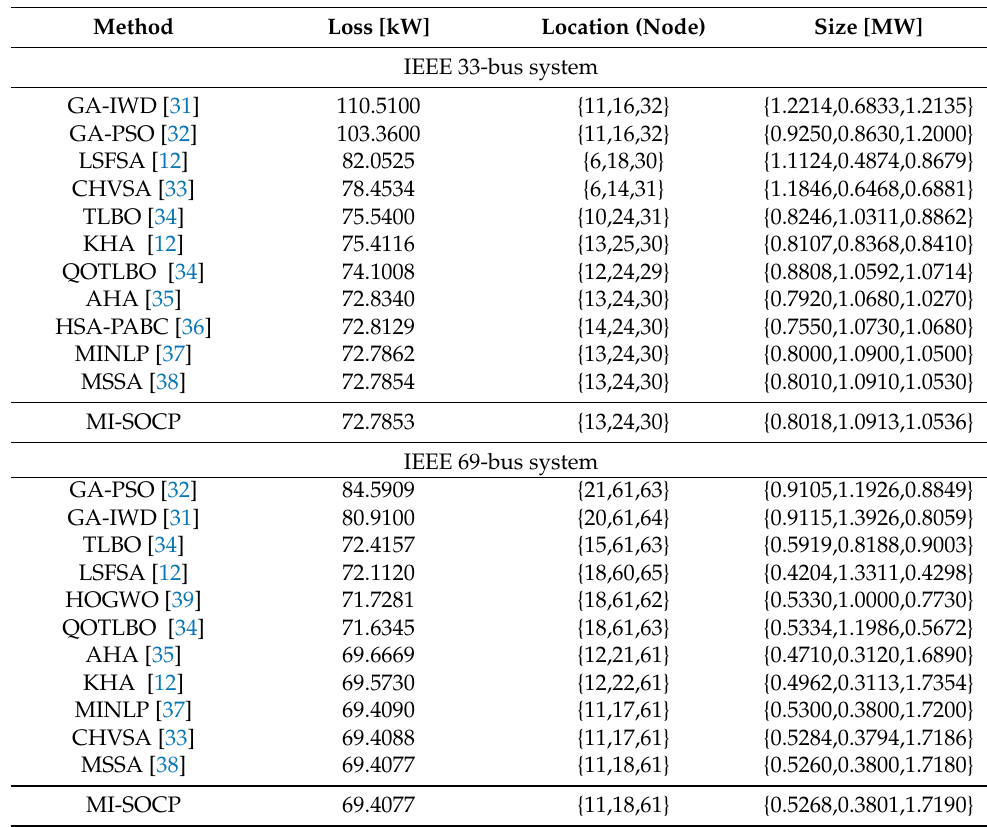
Table 2. Comparative results for the optimal placement and sizing of distributed energy resources (DERs) for the IEEE 33-bus and IEEE 69-bus systems for